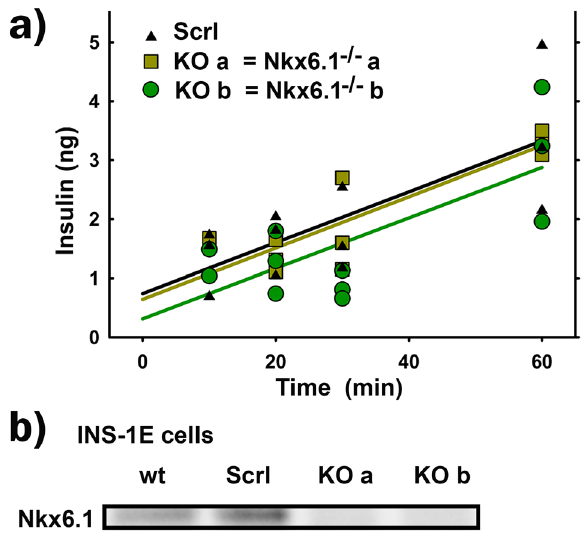
Figure 1. ( a ) Insulin secretion kinetics is not affected by Nkx6.1 ablation—insulin secretion was assayed in triplicates for control INS-1E scrl/scrl cells ( black ) or lines ( a ) ( yellow green ) and ( b ) ( green ) of INS-1E Nkx6.1 – / – cells, when stimulated with 20 mM glucose adjustment after 1-h preincubation in the KRH medium, containing 3 mM glucose. Data were fit by linear regressions yielding GSIS rates of 101% ± 20% and 99% ± 30% for lines ( a ) and ( b ) relatively to INS-1E scrl/scrl cells. ( b ) Nkx6.1 protein